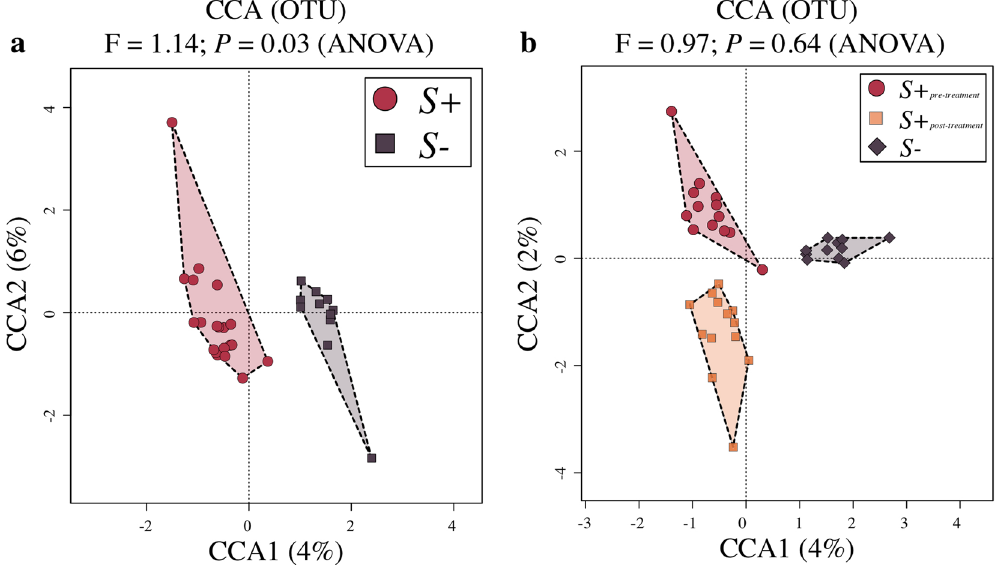
Figure 2. The faecal microbial profiles of Strongyloides stercoralis -infected individuals and uninfected controls. Differences between the faecal microbial profiles of S . stercoralis infected and uninfected subjects ( S + and S − , respectively) ( a ), and between the microbial profiles of the subset of S + subjects that had received anthelmintic treatment, both prior to ( S + pre-treatment ) and 6 months post-ivermectin administration ( S + post-treatment ), and of S − subjects, ordinated by supervised Canonical Correspondence Analysis (CCA; b